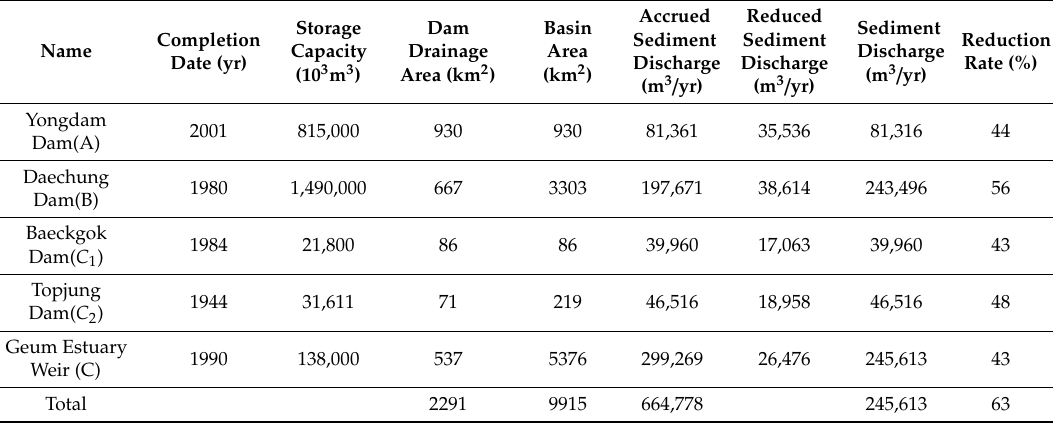
Table 5. Estimated sediment discharge in Geum